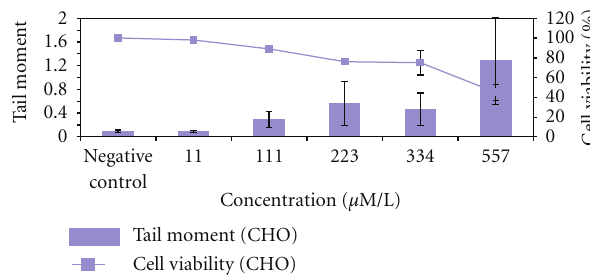
Figure 5: Genotoxicity of Me 3 As in CHO-9 cells after 1h exposure time measured by Comet-Assay. The tests were repeated three times.